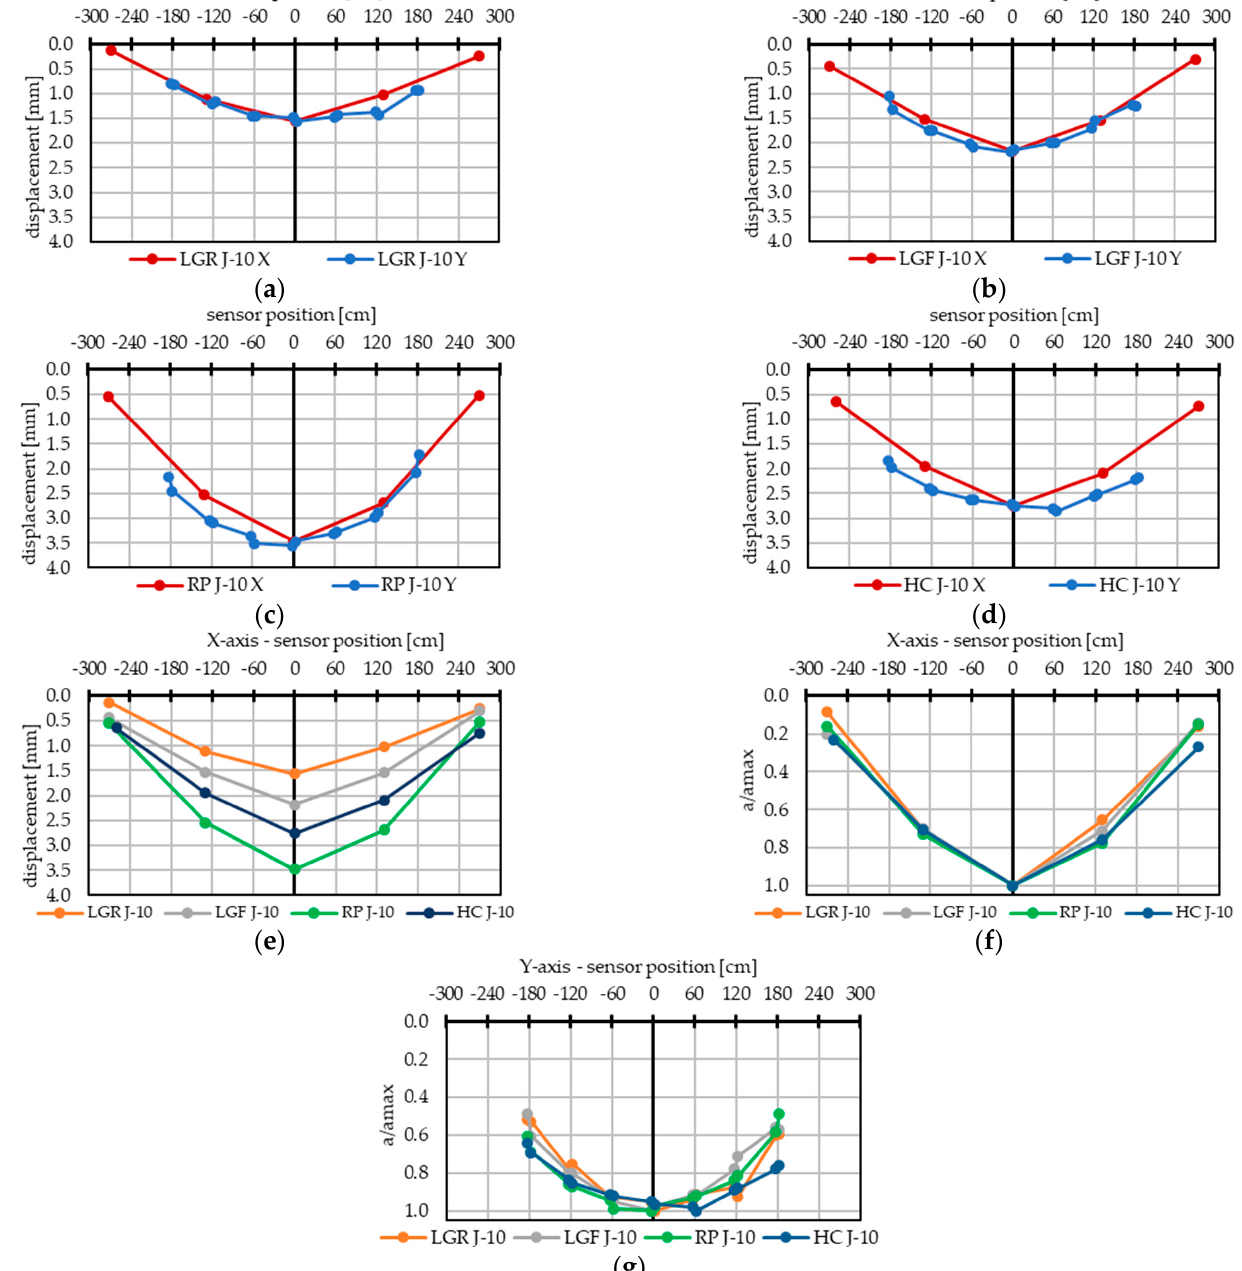
Figure 16. Displacements in the X- and Y-axes for sequence J-10: ( a ) LGR; ( b ) LGF; ( c ) RP; ( d ) HC. ( e ) Comparison of panels, ( f ) performance of panels in the X-axis, and ( g ) performance of panels in the Y-axis. Table 4. Maximum displacements of individual models under successive loading sequences.